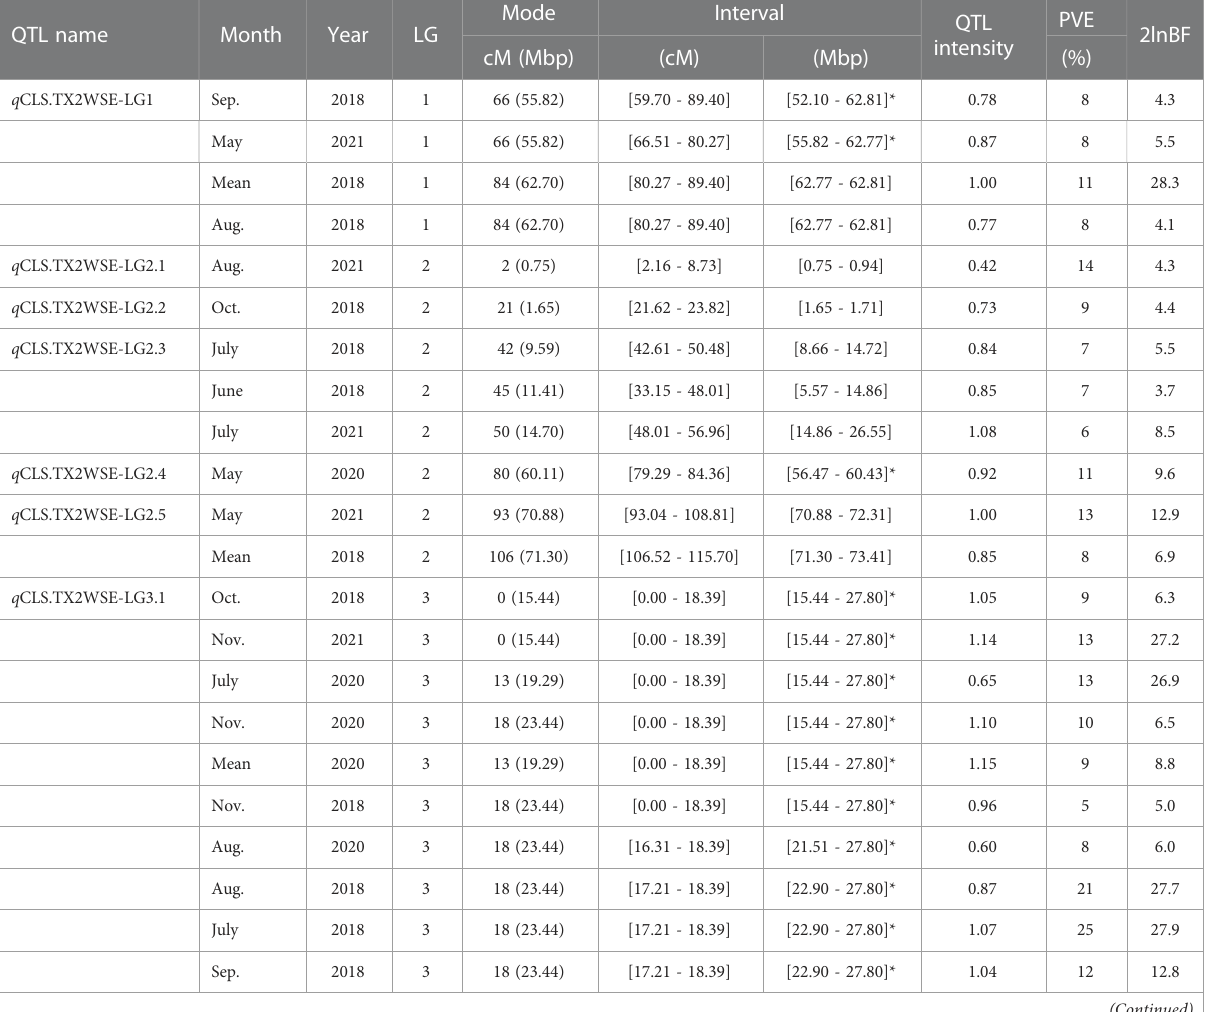
TABLE 2 QTL name, linkage group (LG), interval, QTL peak mode (Mode), posterior intensity (QTL intensity), phenotypic variance explained (PVE), and Bayes factor (2lnBF) for the cercospora leaf spot (CLS) evaluated in Texas on six diploid rose populations (TX2WSE) across multiple months